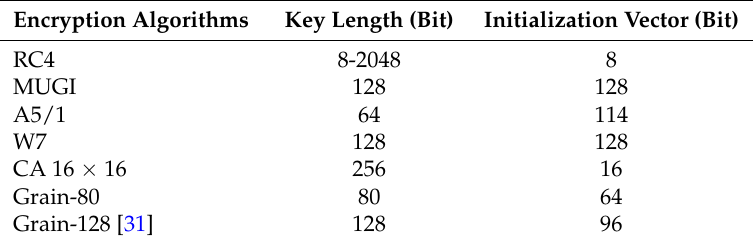
Table 4. Functional characteristics of the pseudorandom